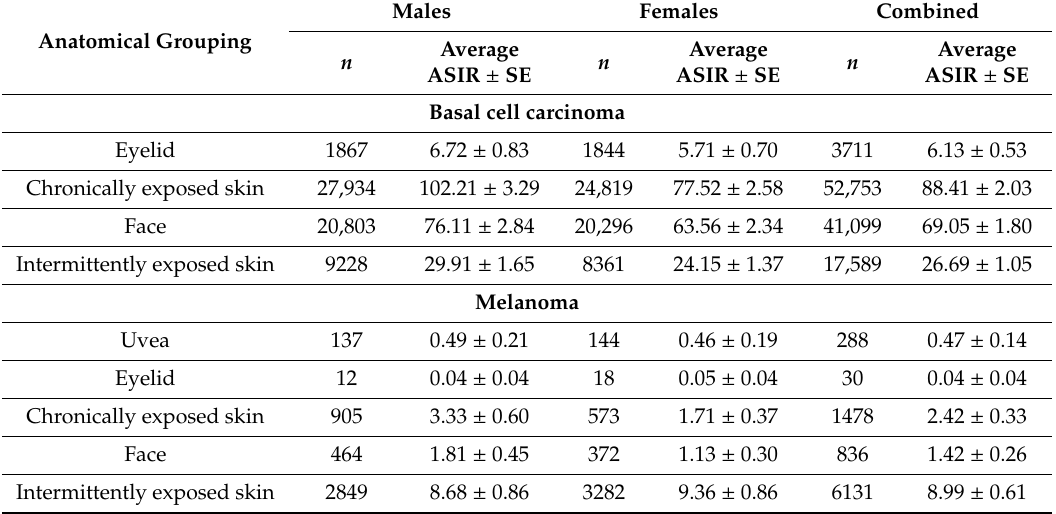
Table 1. Average age-standardized incidence rates (ASIRs) for ophthalmic and non-ophthalmic basal cell carcinoma and melanoma, 1982–2007.